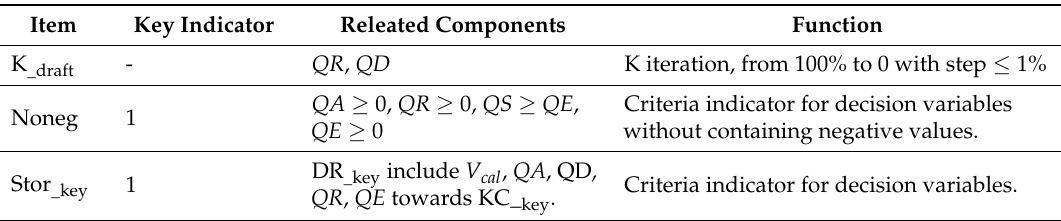
Table 3. Criteria for termination status.